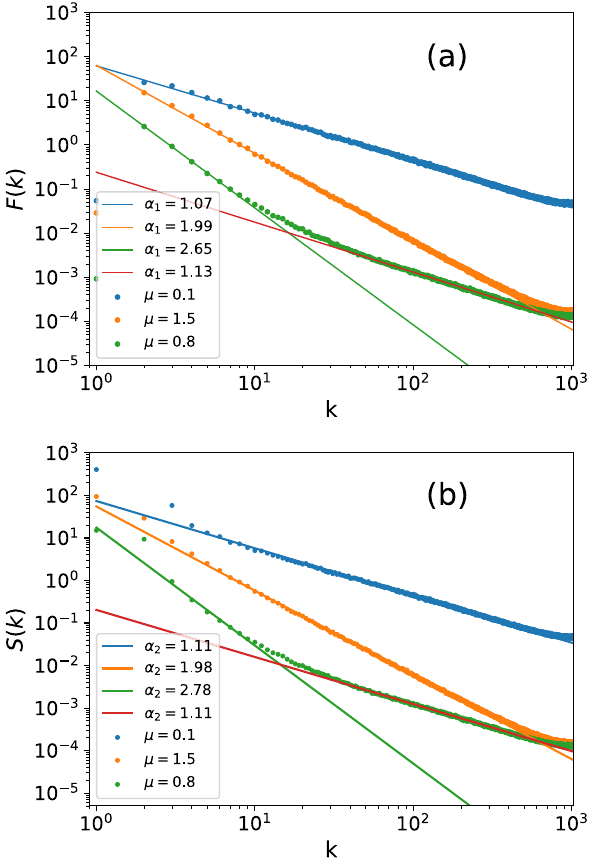
Figure 3. Two kinds of power-spectrum functions— F ( k ) in Eqs. (4), (5) and S ( k ) in Eqs. (6) and (7), they show very similar scaling behaviors to (cid:31) k shown in Fig.1b, suggesting that they contain essentially identical